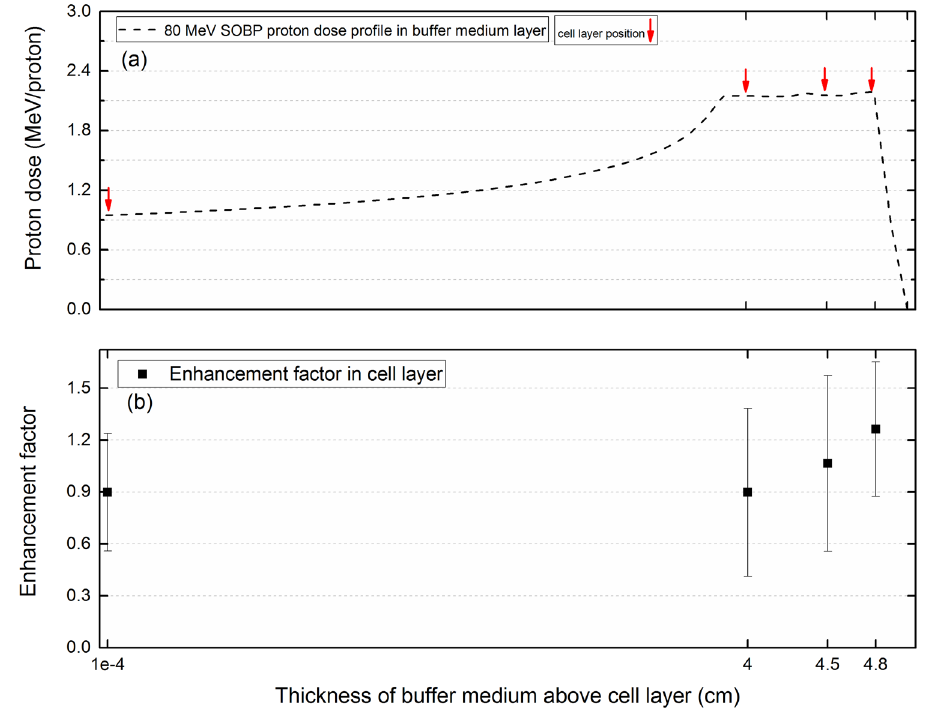
Figure 12. The ( a ) SOBP profile in the buffer medium layer and ( b ) enhancement factors obtained in the monolayer cell array placed underneath of the buffer medium layer. (Red arrows represent the cell array